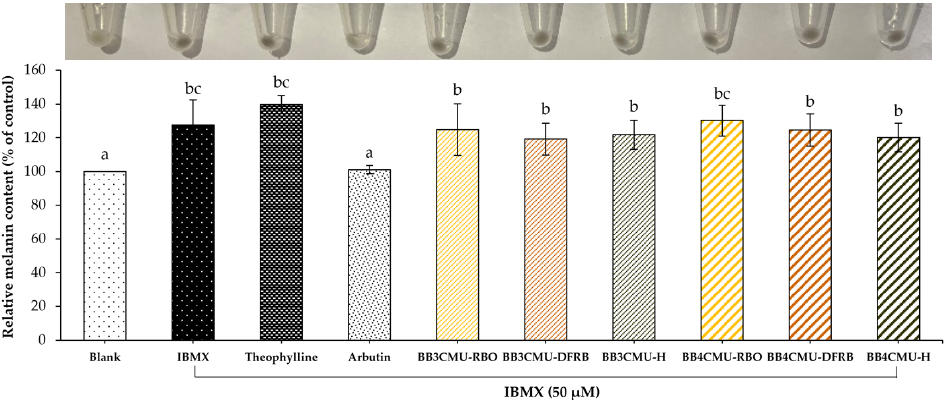
Figure 1. Effects of Oryza sativa L. cv. BB3CMU and BB4CMU extracts at 0.01 mg/mL on melanin content in B16F10 melanoma cells stimulated with 50 µM 3-isobutyl-1-methylxanthin (IBMX) for 48 h. Theophylline and arbutin (0.01 mg/mL) were used as standard controls. Cells cultured in the medium without treatment refer to the blank. Different letters within each treatment indicate sig- nificant differences ( p < 0.05).